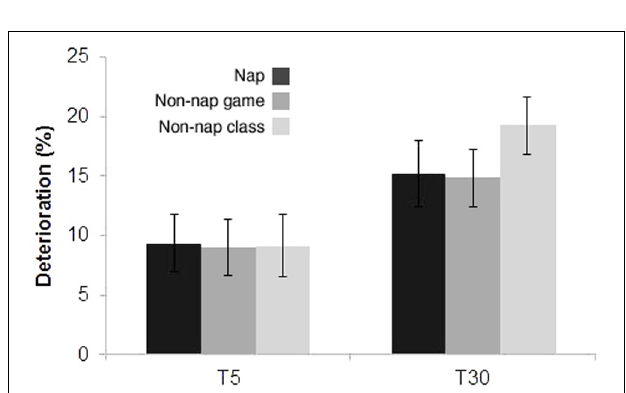
FIGURE 5 | Experiment II—Learning deterioration over time. Difference in performance, from T0 to T5 or T30.